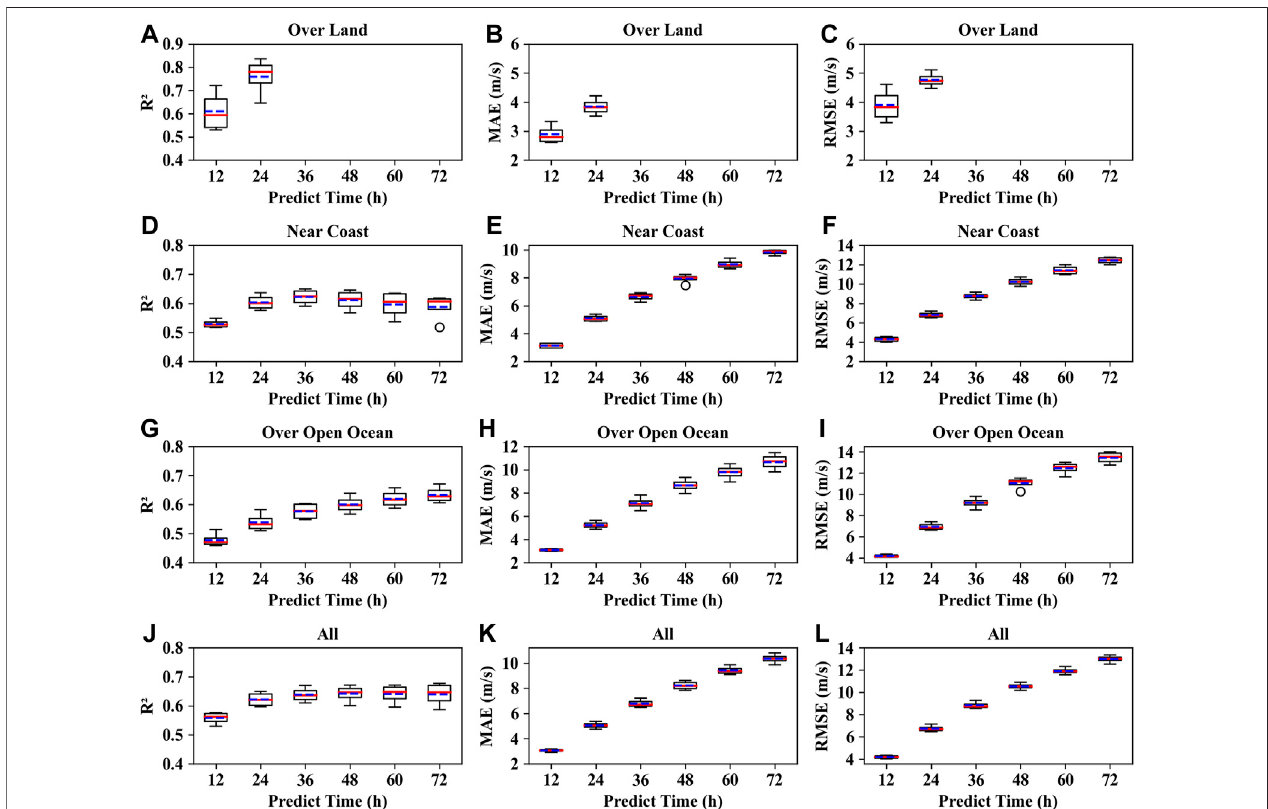
FIGURE5| EvaluationoftheperformanceoftheGBRTmodelinpredictingtheTCsfuture12,24,36,48,60,and72-hintensitychangeswithfourcrossvalidations in terms of R 2 (the fi rst column), MAE (the second column), and RMSE (the third column) based on the JTWCTCs best track data. (A – C) for TC samples over land; (D – F) for TC samples near the coast; (G – I) for TC samples over the open ocean; (J – L) for all TC samples.